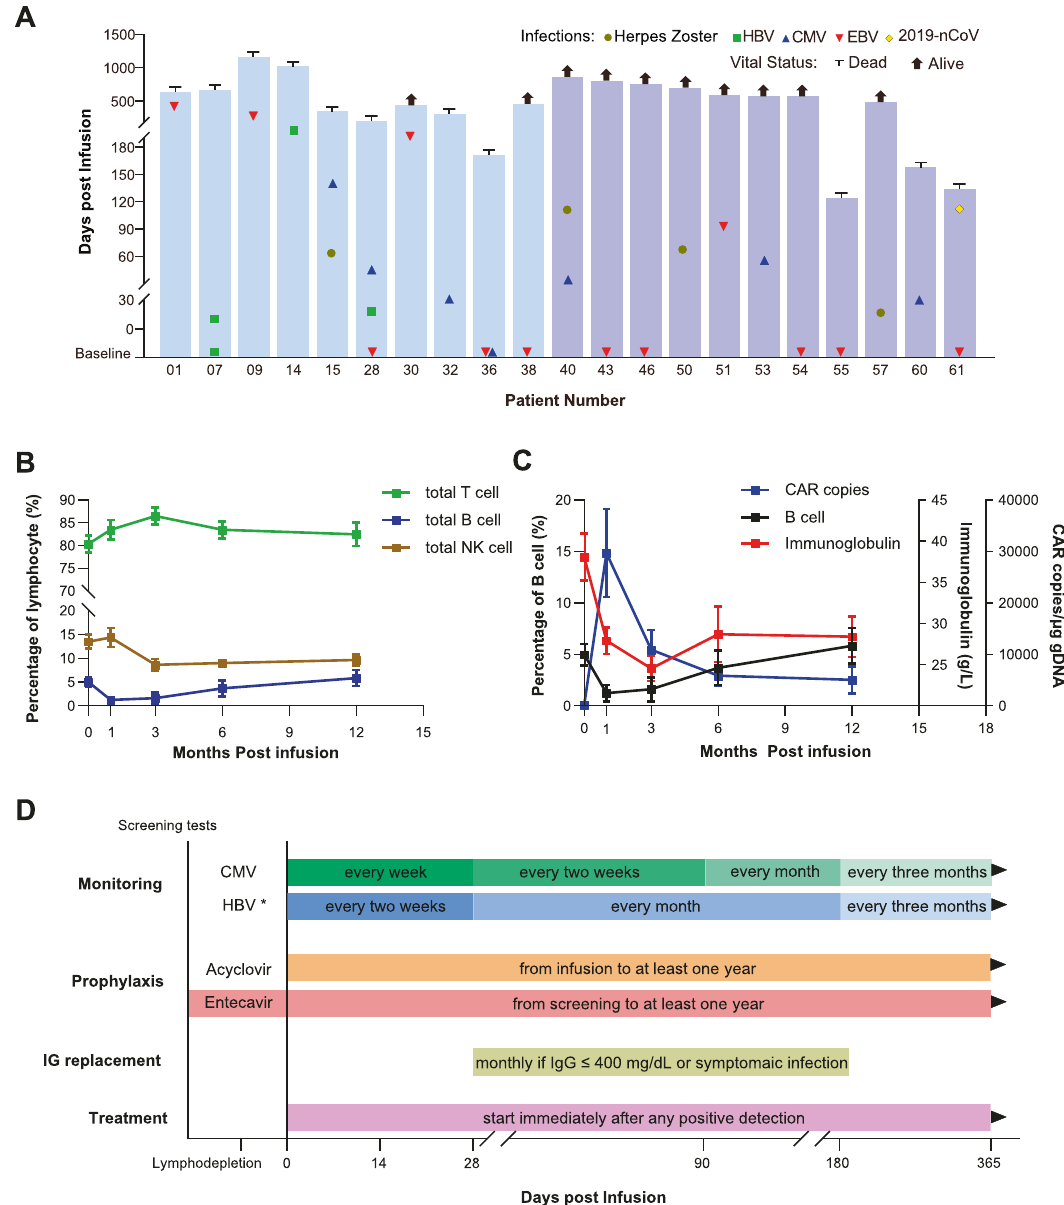
Fig. 1 Viral infections, changes of immune system, and recommendations of viral management in patients receiving BCMA-targeting CAR T-cell therapy. A All infection events detected from screening till the data cut-off date or last follow-up are shown; each symbol represents a virus type. The blue and purple bars represent the overall survival of patients receiving mouse- and fully human-originate anti- BCMA CAR, respectively. The viral DNA replication detected at screening was marked on the baseline, including one HBV, one CMV, and eight EBV cases. After anti-BCMA CAR T-cell infusion, 18 viral infection/reactivation events were recorded, including four EBV, six CMV, three HBV, four herpes zoster, and one COVID-19 case. Most events were recorded within the fi rst 6 months post infusion. B The percentage of lymphocyte subpopulations, including T cells, B cells, and NK cells, was analyzed by fl ow cytometry. B cells and NK cells fell to the nadir at the fi rst and the third months post infusion, respectively, while T cells peaked at 3 months post infusion. The bar at each point represents the standard error of the mean. C BCMA CAR transgene and immunoglobulin levels in patients were tested post infusion. BCMA CAR transgene reached the peak at the fi rst months, which was parallel with the depletion of B cells. Decrease of immunoglobulin fell behind the B cells depletion and recovered from the sixth month. The bar at each point represents the standard error of the mean. D At the time of patient enrollment, screening tests of common viruses, such as HBV, HCV, HIV, CMV, and EBV, would be needed. Regular monitoring of viral nucleic acid after anti-BCMA CAR infusion is recommended. Long-time entecavir prophylaxis is necessary for patients with HBV infection, and acyclovir prophylaxis is recommended for all patients. Immunoglobulin replacement is preferred for patients with IgG ≤ 400 mg/dL or symptomatic infection. Antiviral treatment would be needed immediately after positive viral fi ndings except for EBV. Abbreviations: CMV, cytomegalovirus; EBV, Epstein-Barr virus; HBV/HCV, hepatitis B/C virus; HIV, human immunode fi ciency virus; IG, Immunoglobulin. *Only patients who are con fi rmed with HBV infection (including chronic and resolved infection) need regular monitoring of viral nucleic acid post